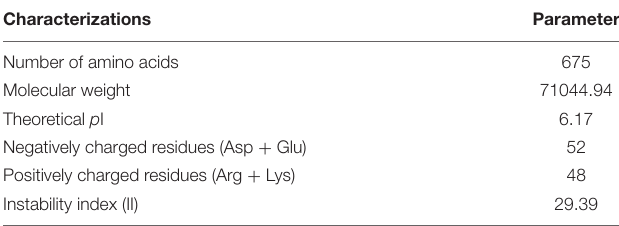
TABLE 1 | Physic-chemical property analysis of